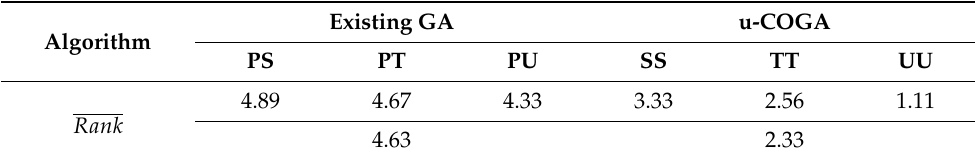
Table 9. Average ranks of the